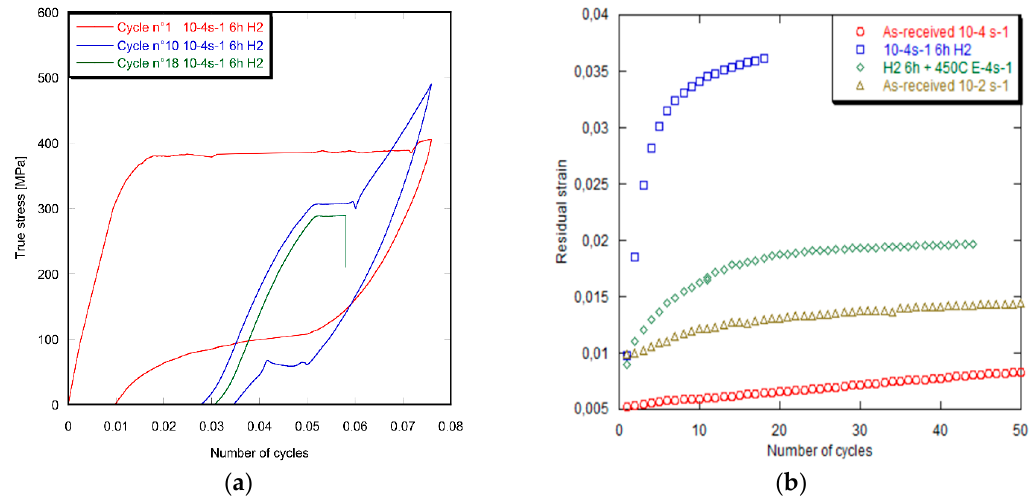
Figure 6. After 6 h of hydrogen charging and ageing ( a ) tensile loading and unloading with imposed strain rate of 10 − 4 s − 1 and ( b ) evolution of residual strain at zero stress with number of cycles. In comparison to the as-received specimen with an imposed strain of 10 − 4 s − 1 , it is clear that the